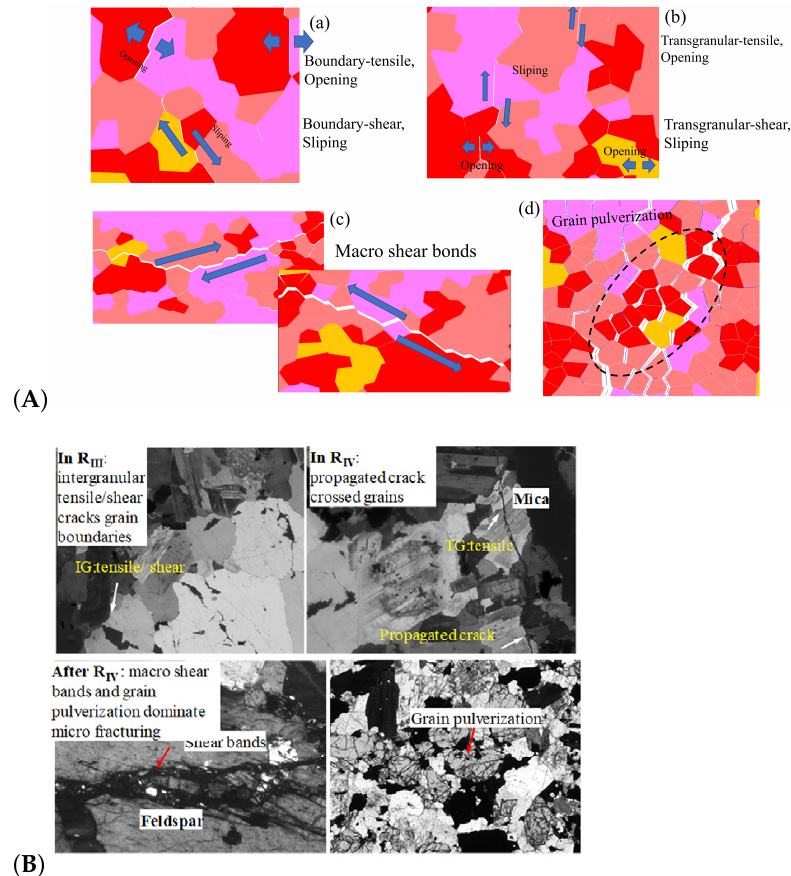
Figure 12. Typical micro-fracture characteristics during the four damage stages of Stage III, Stage IV, Stage V and VI: ( A ) Micro-fracture characteristics shown in numerical simulation. ( B ) Micro-fracture characteristics observed in experiments [7].